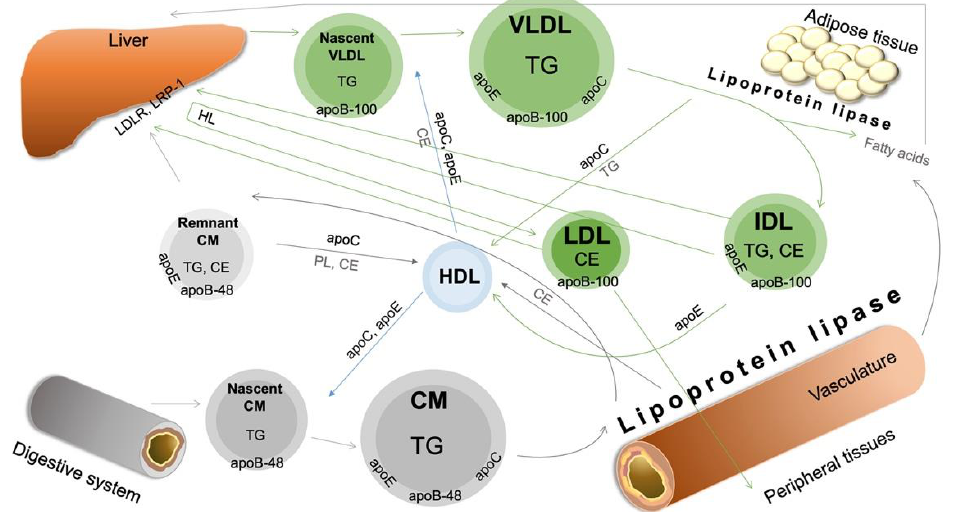
Figure 1. Overview of physiological lipoprotein metabolism. Apo—apolipoprotein; CE—cholesteryl ester; CM—chylomicron; HDL—high-density lipoprotein; HL—hepatic lipase; IDL—intermediate- density lipoprotein; LDLR—low-density lipoprotein receptor; LRP-1—LDL receptor-related protein 1; PL—phospholipid; TG—triglyceride; VLDL—very-low-density lipoprotein. For description and references, please see the text.